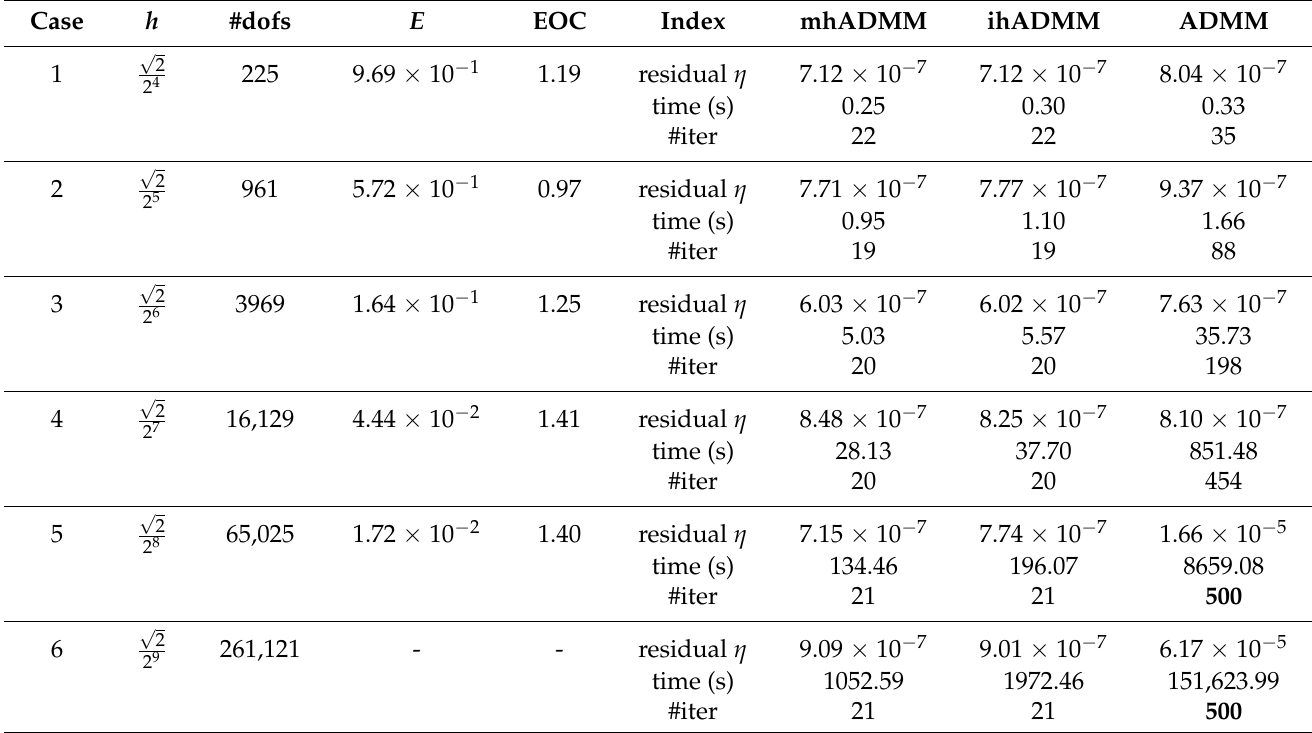
Table 2. The convergence behavior of the mhADMM, the ihADMM and the classical ADMM for Example